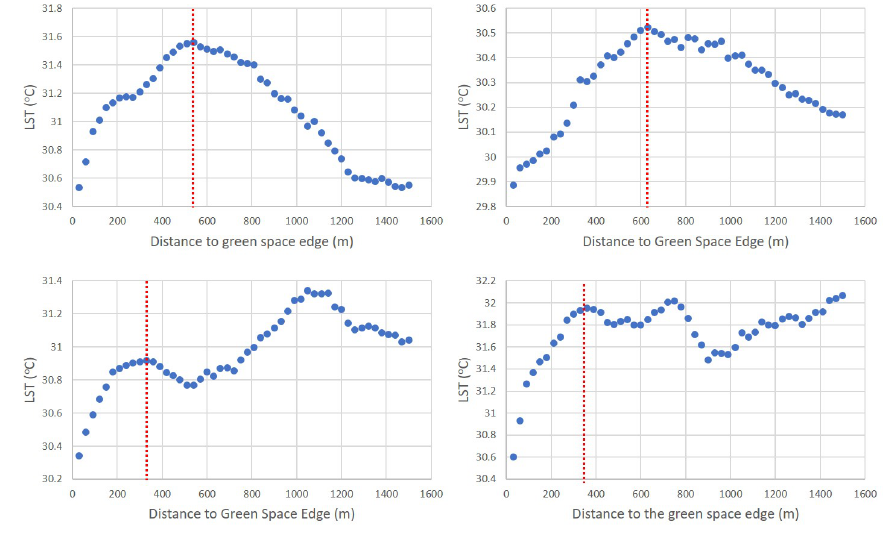
Figure 7. Examples of temperature curves drawn from the 30 m buffers outside the